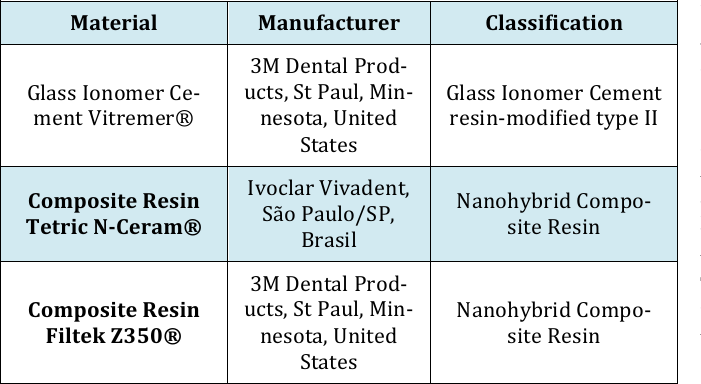
Table 1. Restorative materials used in this study.